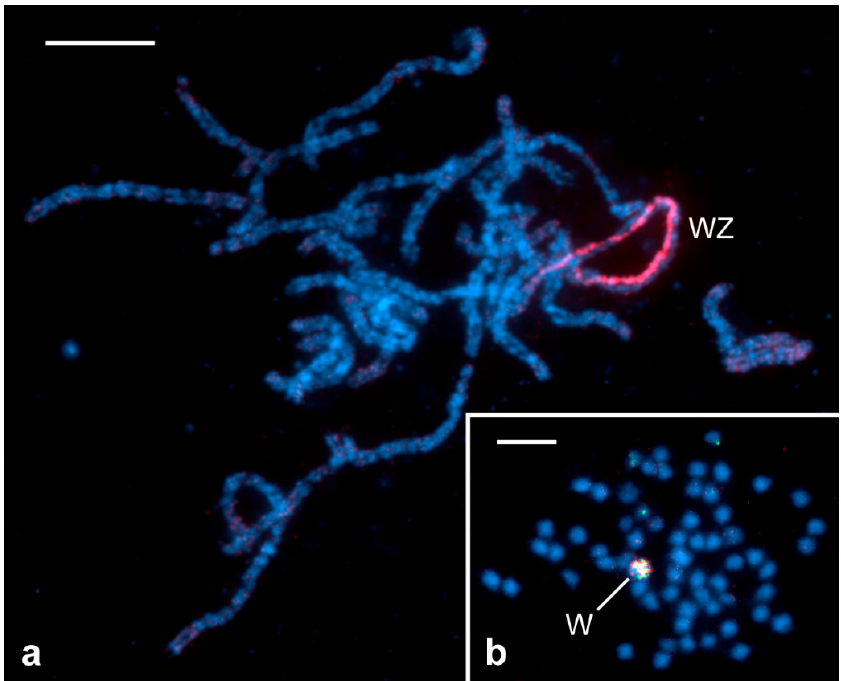
Figure 1. WZ sex chromosome system in Lepidoptera. Chromosomes were stained with DAPI (4’,6-diamidino-2-phenylindole; blue). ( a ) Pachytene oocyte of the codling moth, Cydia pomonella (L.), showing n = 28 meiotic chromosome bivalents; the neo-sex chromosome bivalent (WZ) is identified